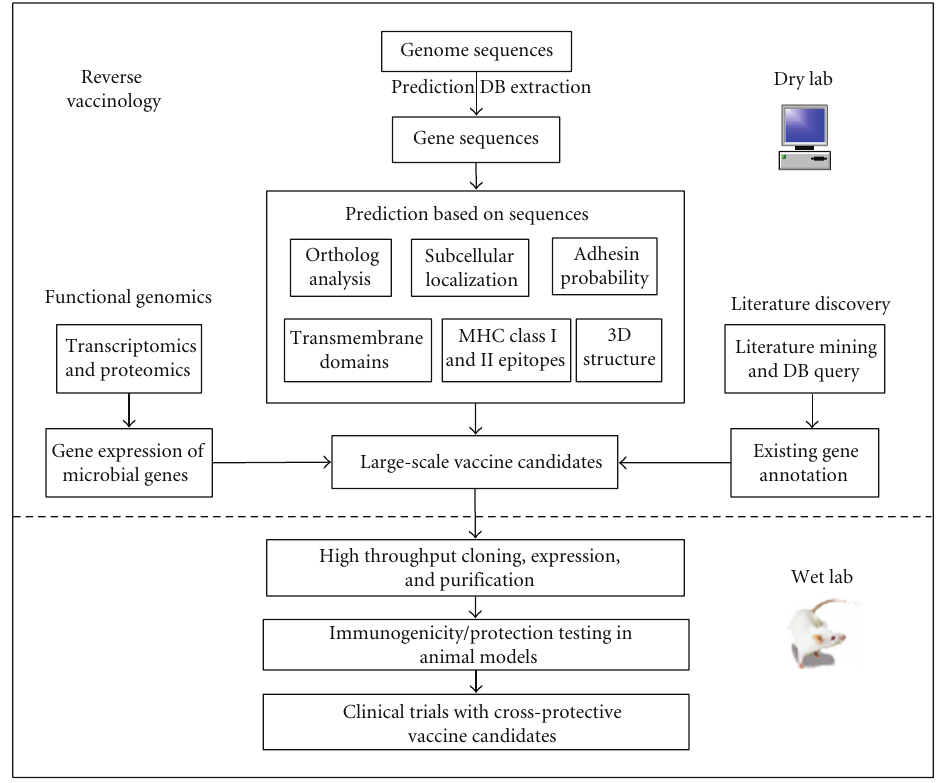
Figure 2: A schematic demonstration of integrative reverse vaccinology strategy towards vaccine